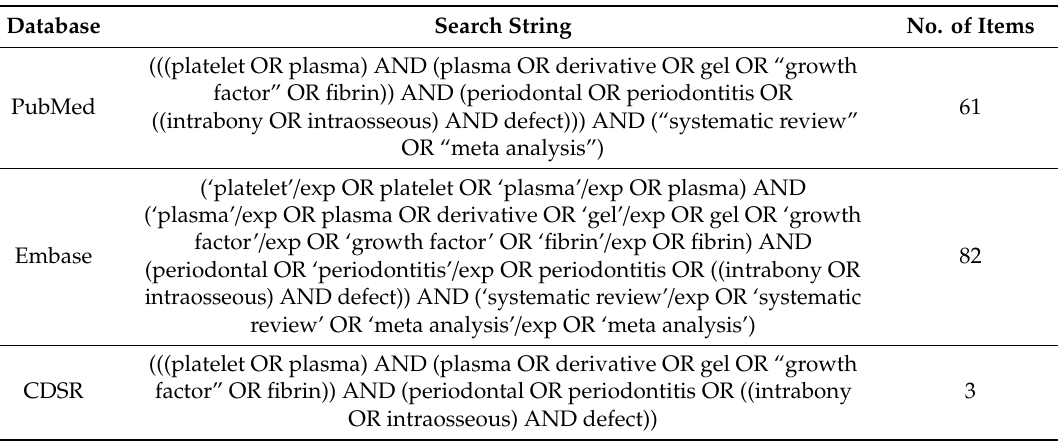
Table 1. Literature search